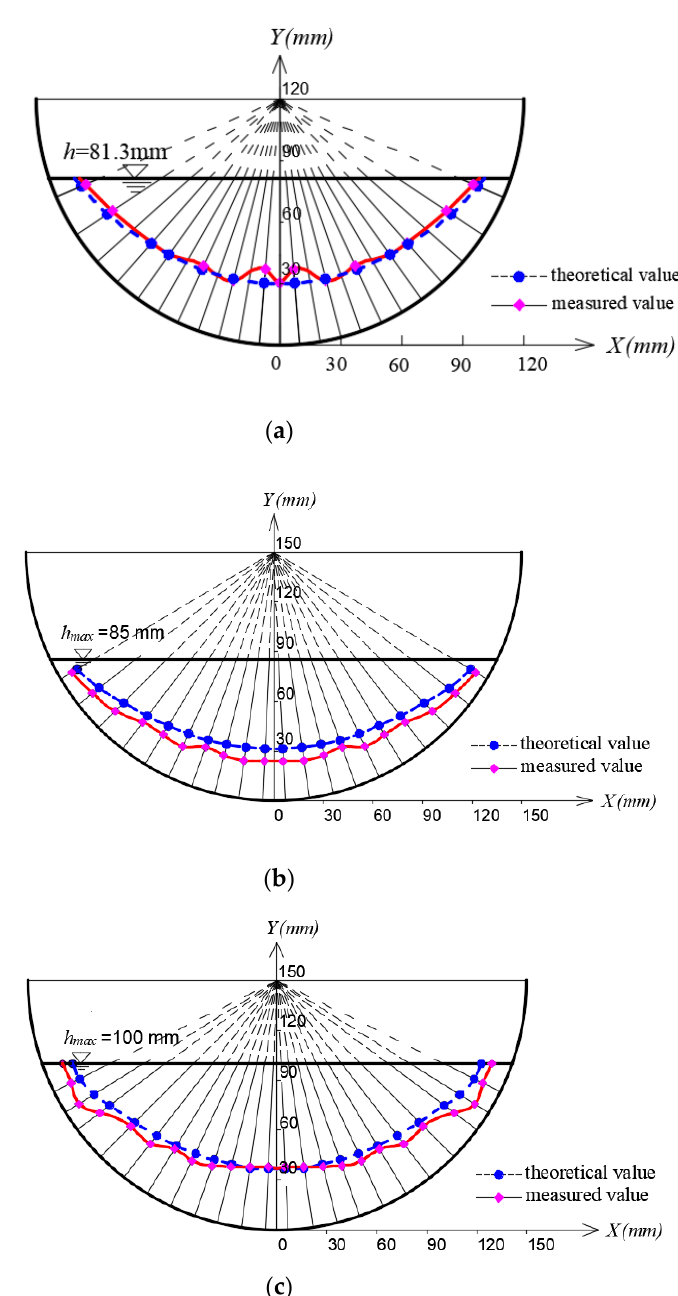
Figure 11. Comparison of measured and theoretical values of CPL ( a ) S1; ( b ) S4; ( c ) S5.